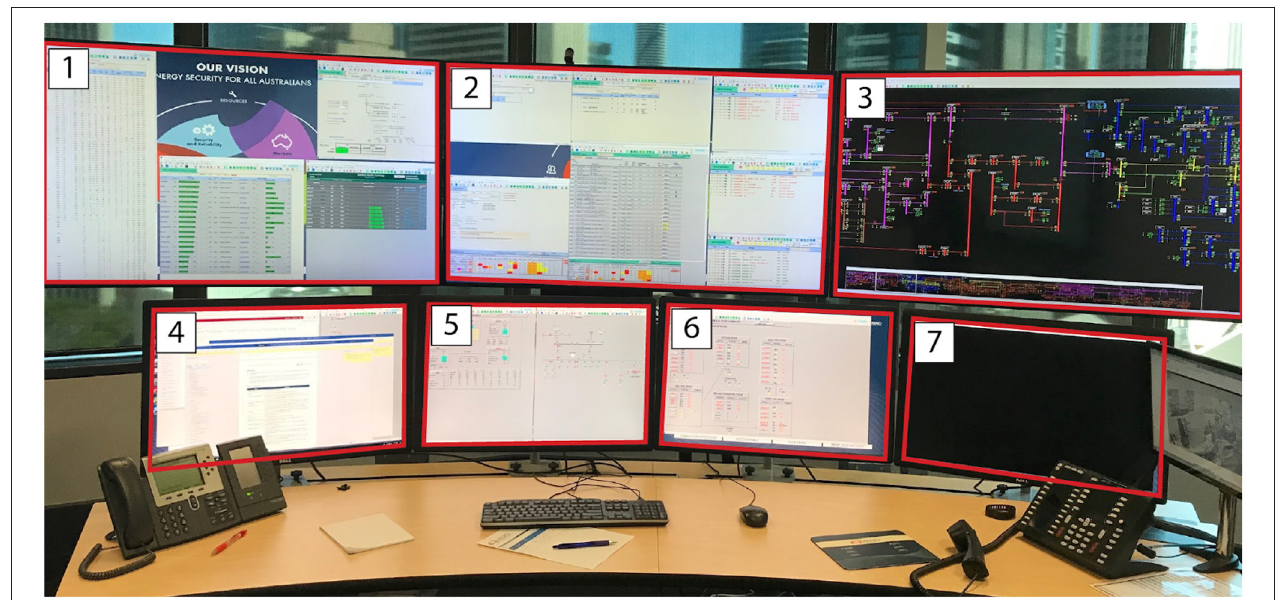
FIGURE 1 | A typical workstation of an operator at the AEMO Brisbane control center, with 7 screens, a mouse, a keyboard, and two phones. The height of the entire desk can be changed by the operator.